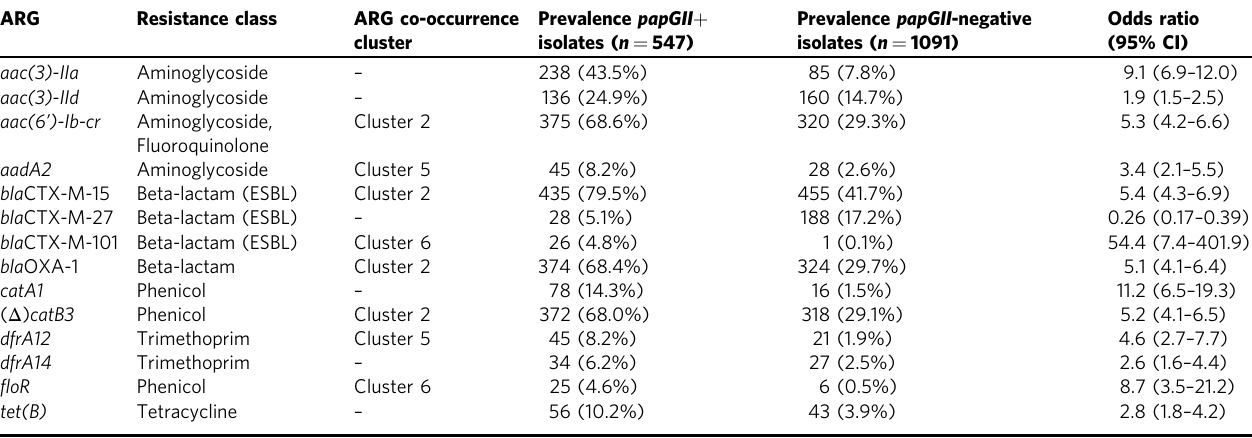
Table 2 Acquired antimicrobial resistance genes (ARGs) signi fi cantly ( P adj a < 0.05) associated with papGII -containing ( papGII + ) versus papGII -negative